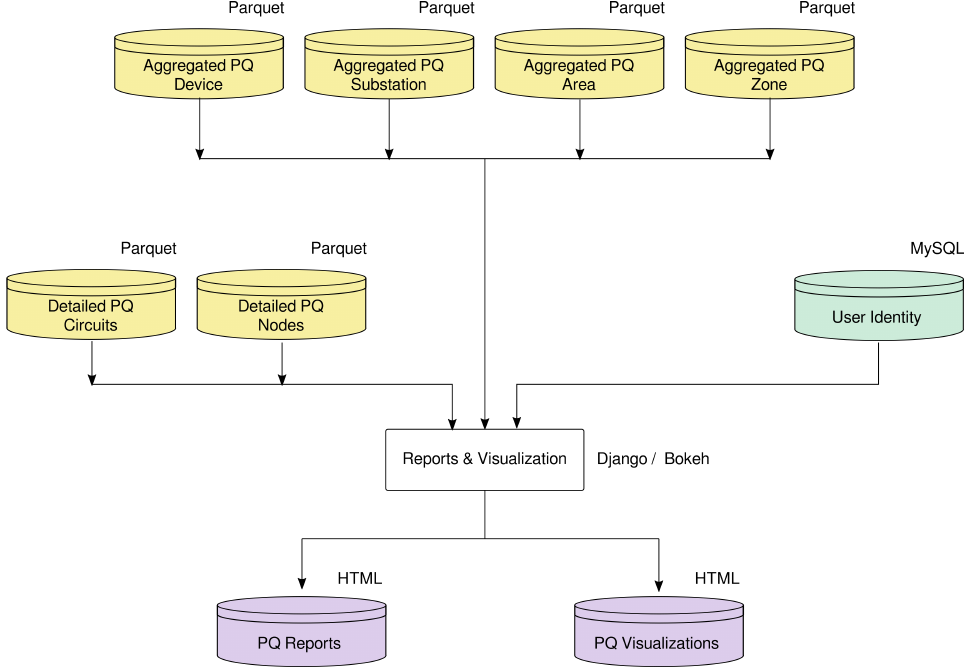
Figure 7. Reports-and-visualization component of MIRD. HTML files for tabular reports and Bokeh interactive plots can be later arranged as personalized analytics